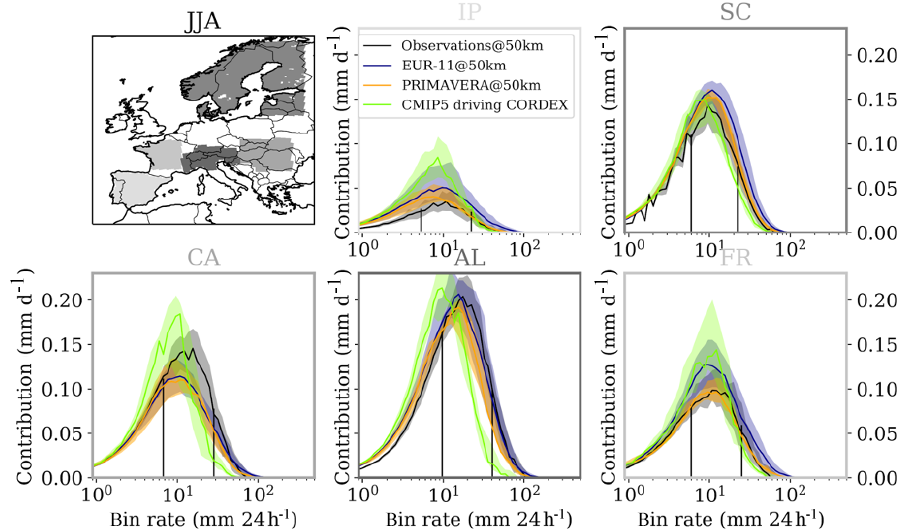
Figure 3. As Fig. 2 for summer